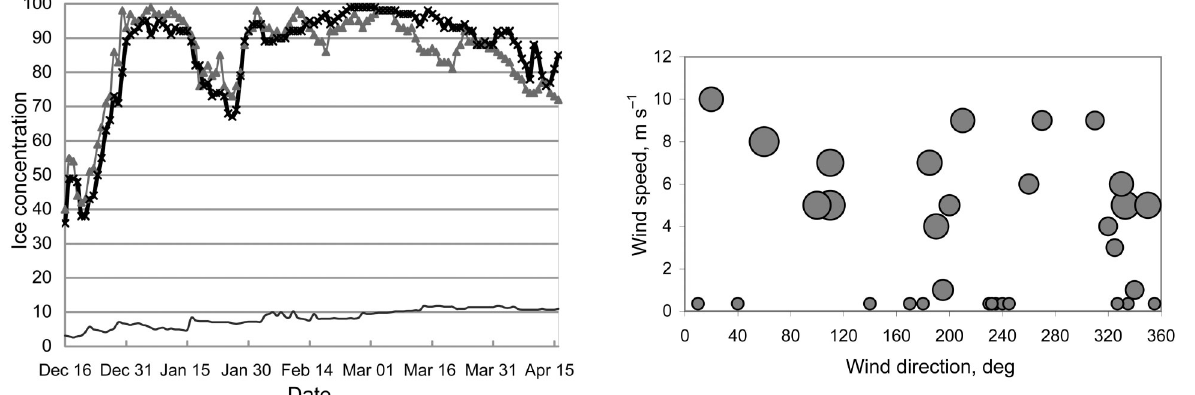
Fig. 8. Growth rate of deformed ice related to wind direction and speed in winter 2002/03. The circles denote the average (over the Gulf of Finland) growth rate from 0.007 m day (cid:150)1 to 0.018 m day (cid:150)1 , as shown by the circle